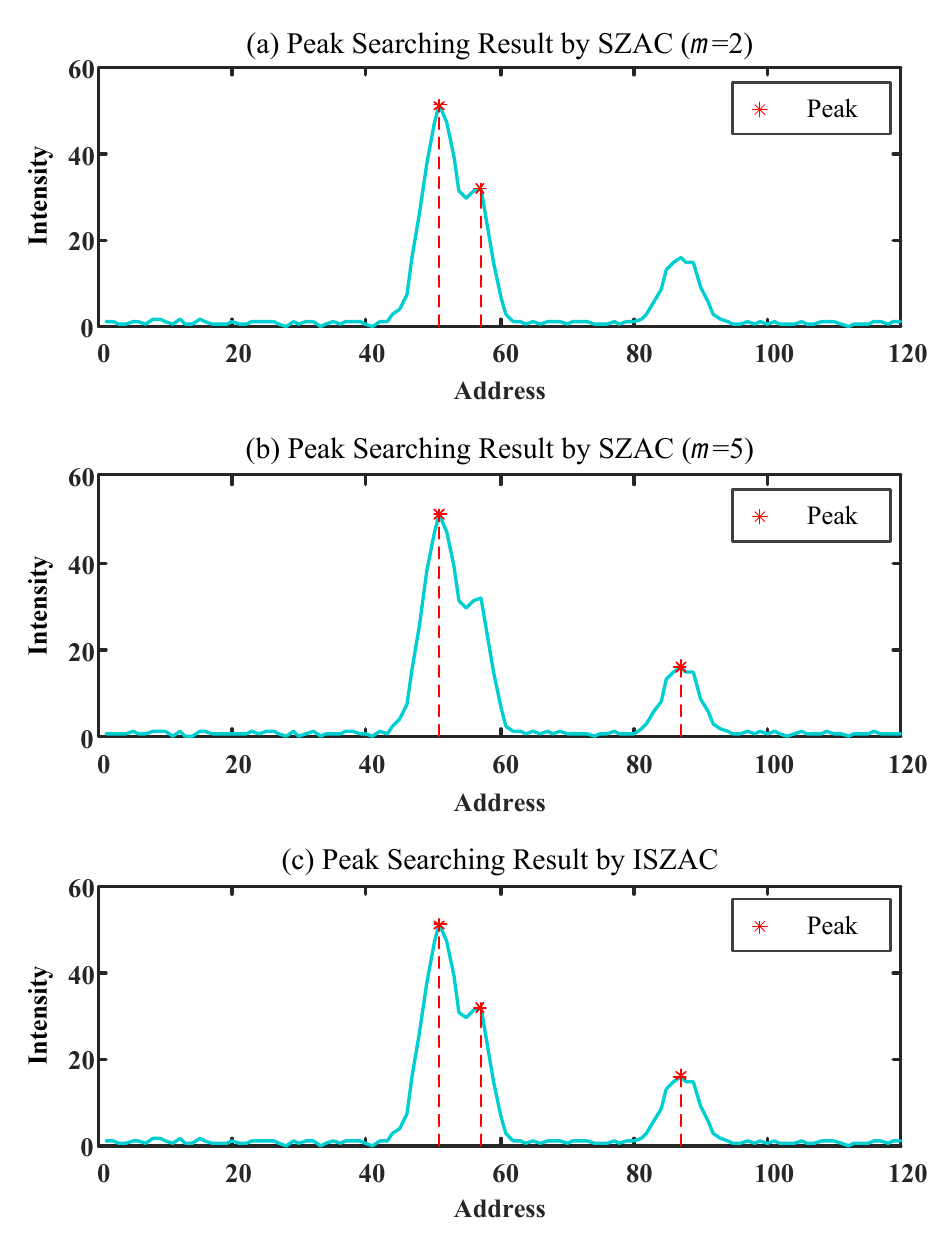
Figure 4. Applicability verification